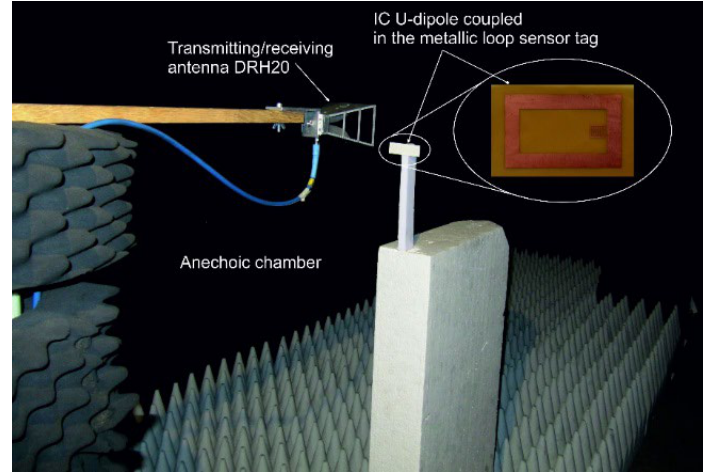
Figure 12. Monostatic measurement setup in anechoic chamber with detail of IC U-dipole coupled in the metallic loop sensor tag.